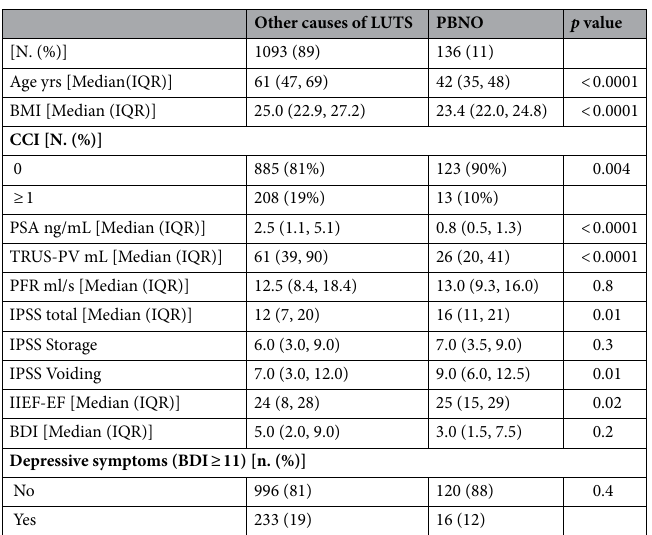
Table 2. Differences in clinical characteristics between patients with and without diagnosis of PBNO. Keys: PBNO = primary bladder neck obstruction; LUTS = lower urinary tract symptoms; BMI = body mass index; CCI = Charlson comorbidity index; PSA = prostate-specific antigen; TRUS = trans-rectal ultrasound; PV = prostate volume; PFR = peak flow rate; IPSS = International Prostate Symptoms Score; IIEF-EF: International Index of Erectile Function-erectile function domain; BDI = Beck’s Inventory for Depression.